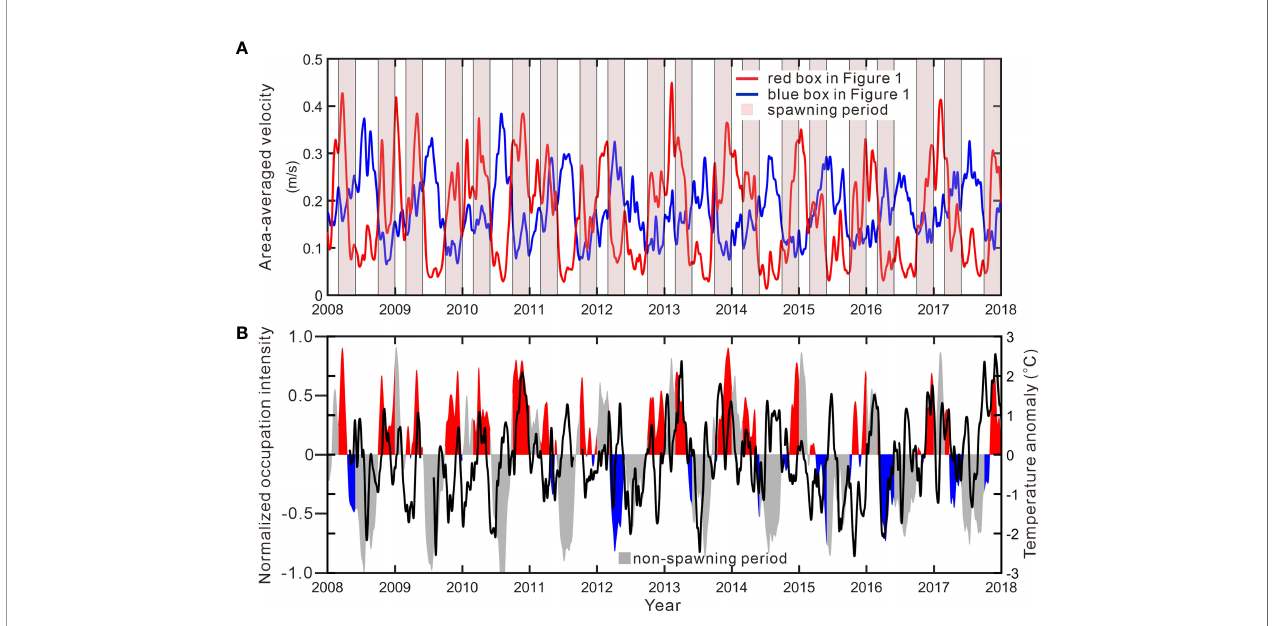
FIGURE 11 | (A) Twenty-day low-pass- fi ltered area average geostrophic velocity as v > 0 (red line) and u > 0 (blue line) in red and blue boxes, respectively, in Figure 1 . Transparent pink shading represent spawning periods of the swordtip squid during 2008 – 2018. (B) Normalized occupation intensity of warm Kuroshio surface water ( fi lled by red during spawning periods) and ECS shelf or Taiwan Strait water ( fi lled by blue during spawning periods). The normalized occupation intensity is de fi ned as the difference between the red and blue lines in (A) divided by the maximum absolute value of the difference. The difference during non- spawning periods is shown in